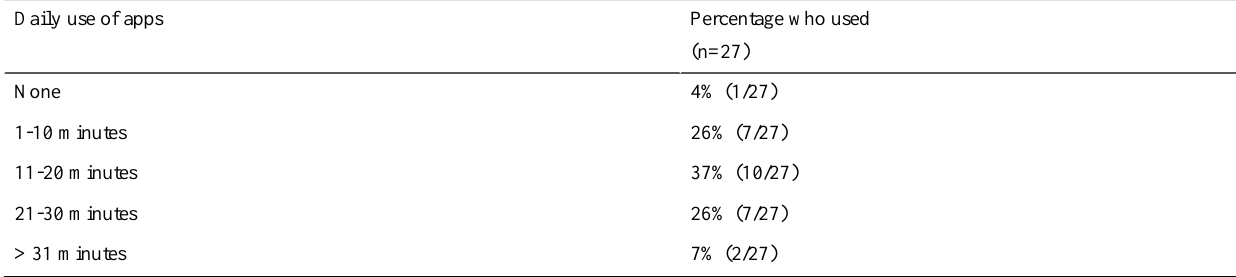
Table 3. Daily use, in minutes, of GPs’medical app use for clinical